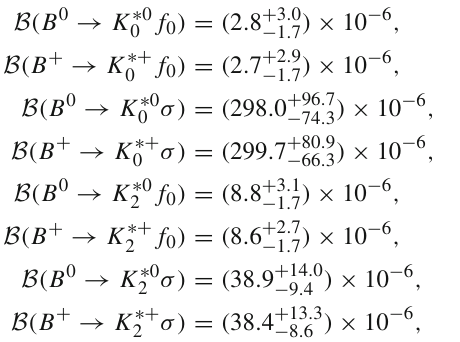
Fig. 3 The branching fractions of B → K ∗ horizontal (green) band is the experimental